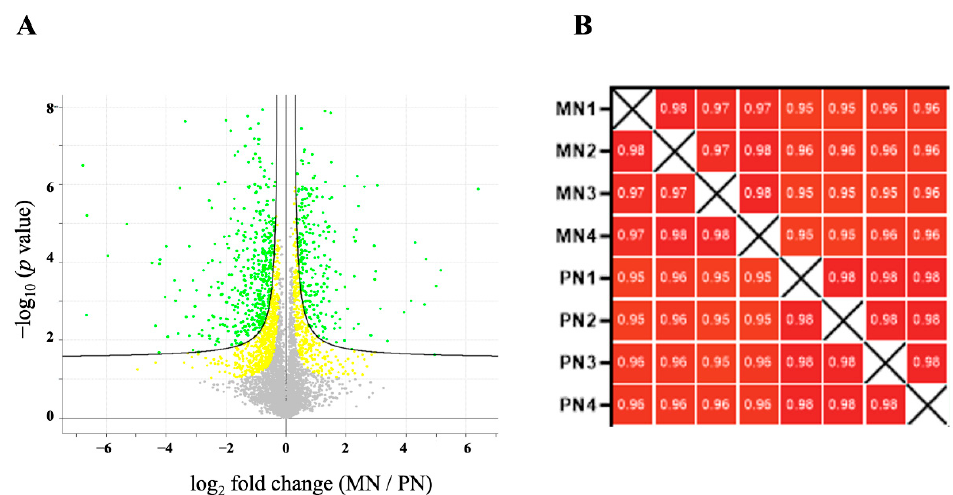
Figure 2. Quantification of the persulfidated proteins identified in root tissue grown in N-starved media compared to N-sufficient nutrient media. ( A ) Volcano plot illustrating significantly differentially abundant proteins. The − log 10 ( p value) is plotted as the log 2 of the fold change between N-starved samples (MN) and N-sufficient samples (PN). Red dots represent protein with FDR < 0.01 and yellow dots FDR < 0.05. ( B ) Pearson correlation coefficients of the four independent N-starved samples (MN) and N-sufficient nutrient samples (PN).